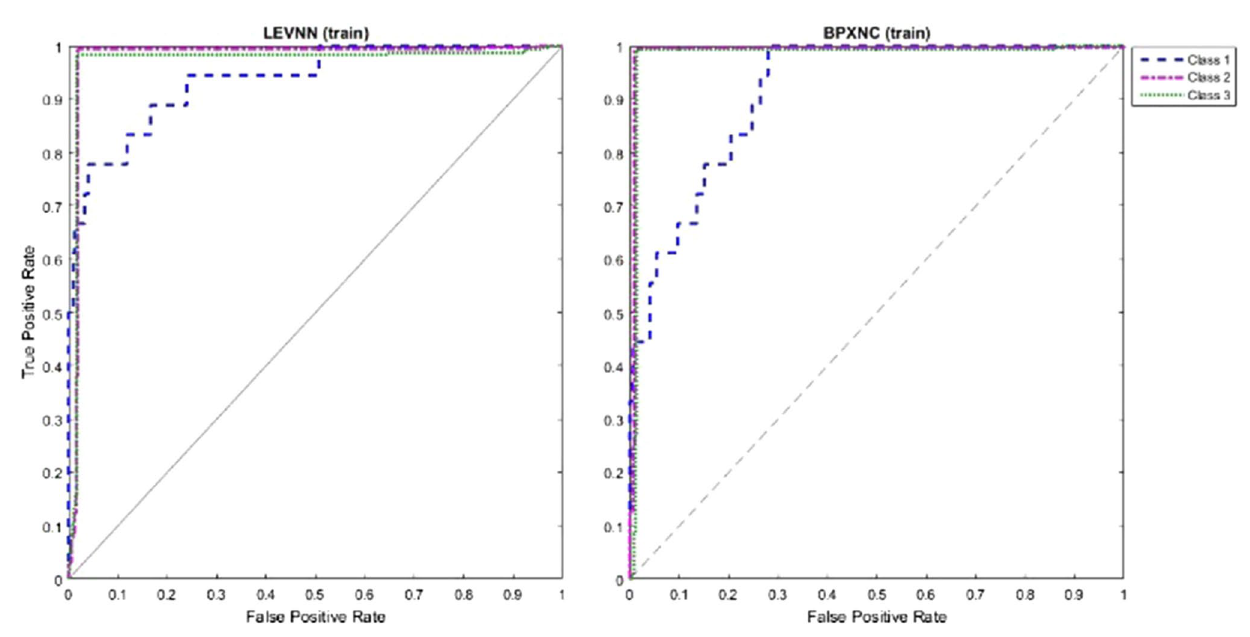
Fig. 10 ROC curve (training) for LEVNN and BPXNC